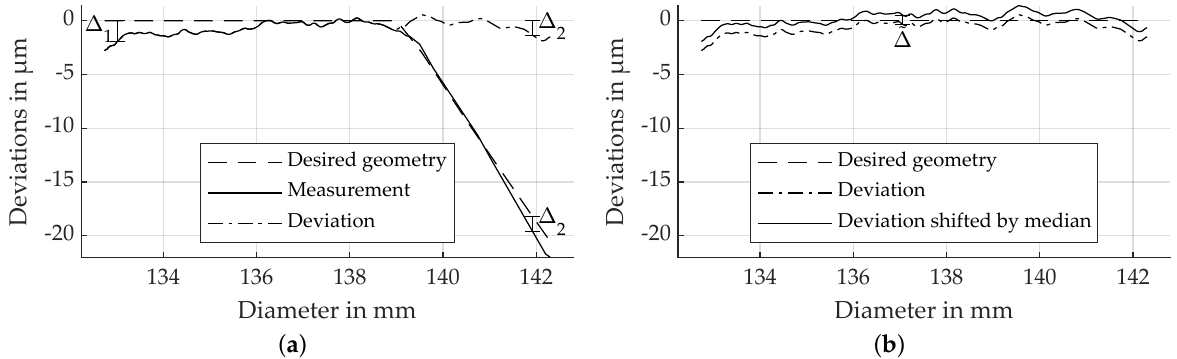
Figure 3. Procedure to obtain the deviations used in this study out of the measured flank and the desired geometry. ( a ) The desired geometry is deduced from the measured profile line in order to obtain the resulting deviations (resulting deviations at two diamters see ∆ 1 and ∆ 2 ). ( b ) In order to compare the results with the other flanks, the resulting deviations are shifted by the median of the deviations in a single flank ˜ ∆ .